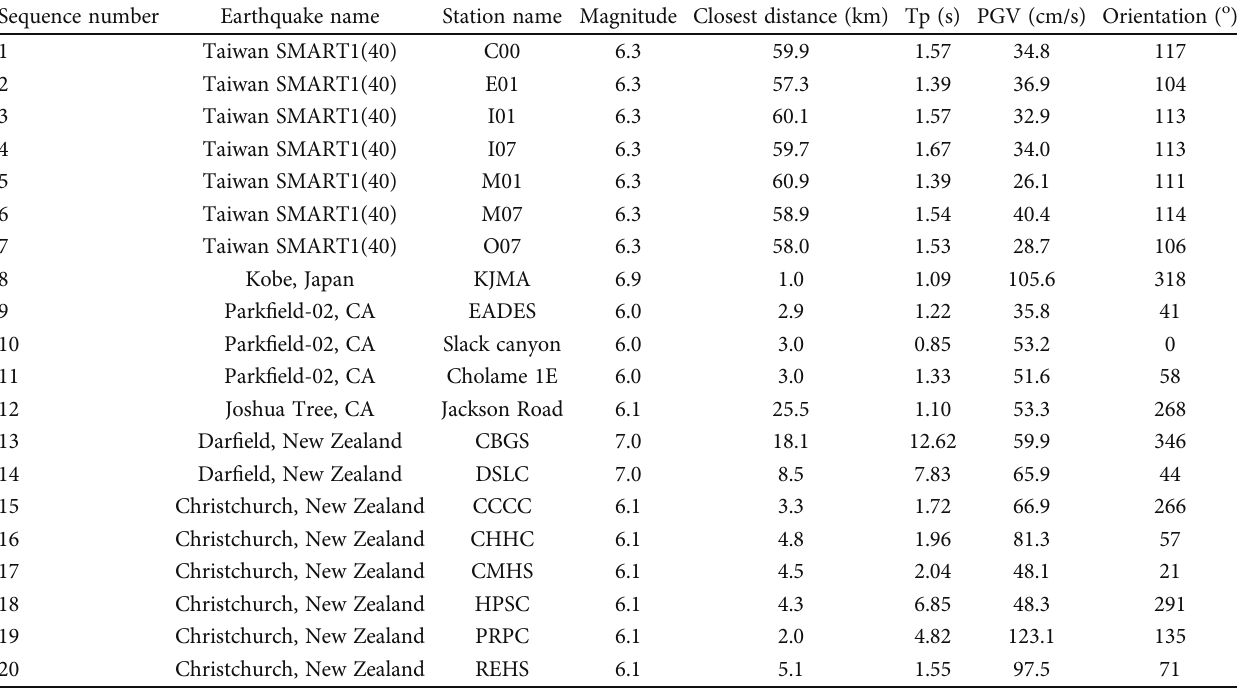
Table 1: List of near-fault earthquakes with pulse-like ground